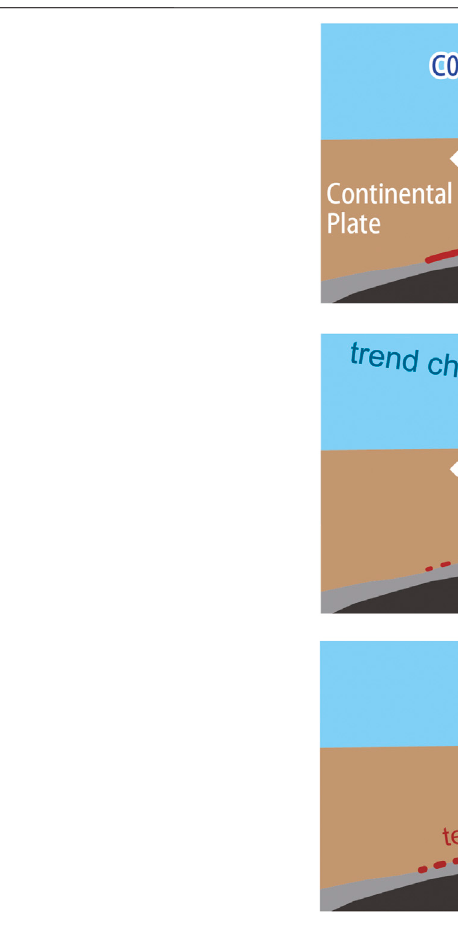
FIGURE 13 | Schematic scenario of the possible process for the SSE with ocean loading (A) during model A-1, (B) during model A-2+, and (C) termination of the SSE.RepresentativefocalmechanismofVLFEisobtainedfromAriyoshietal.(2021).Doublearrowsrepresentvolumetricstrainchangeduetocrustaldeformationdriven by the